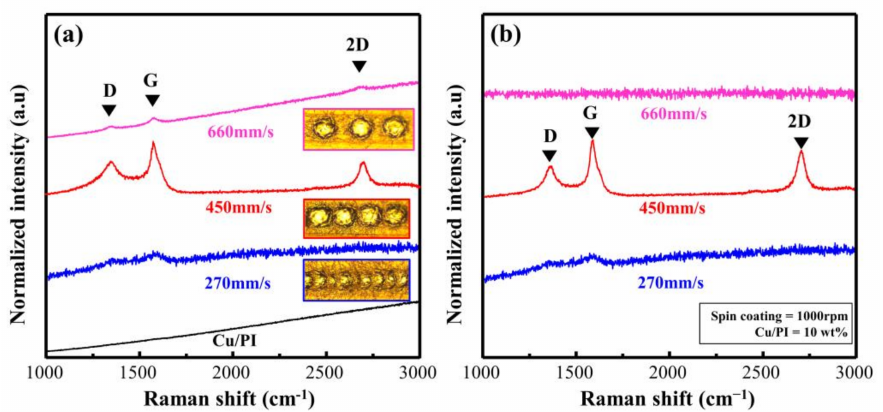
Figure 5. Raman spectra of Cu@LSC with different scan rates ( a ) before and ( b ) after